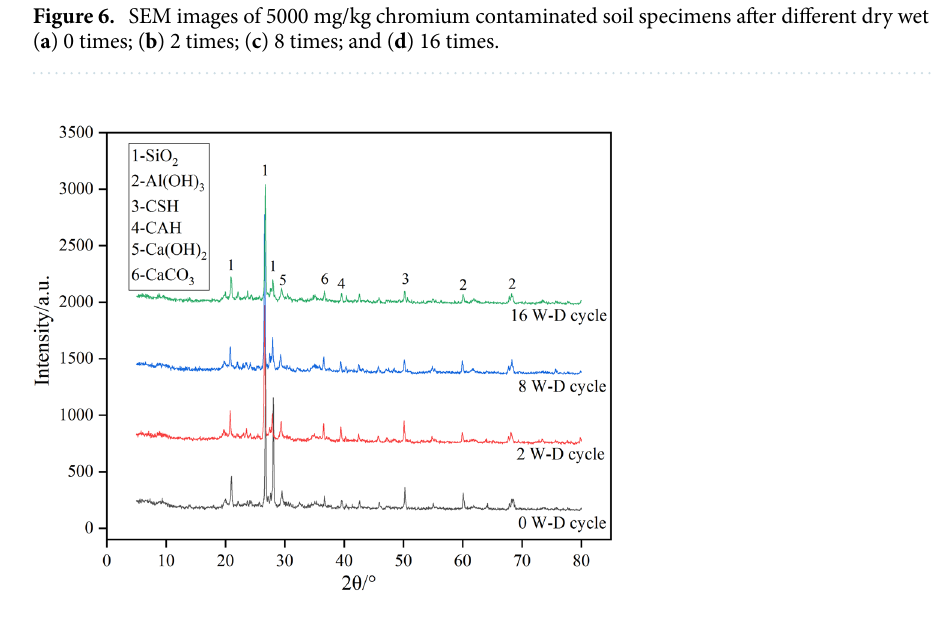
Figure 7. XRD pattern of 5000 mg/kg chromium contaminated soil specimen after different dry wet